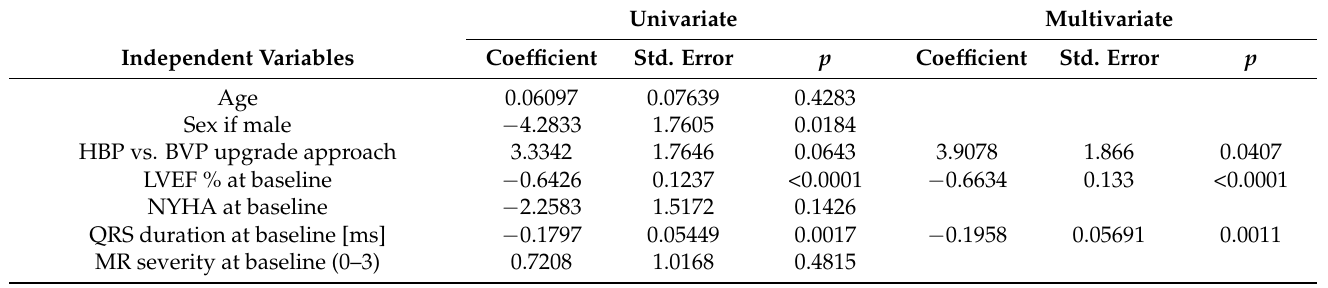
Table 3. Prediction of left ventricle improvement after upgrade procedure in patients with pacing- induced cardiomyopathy.